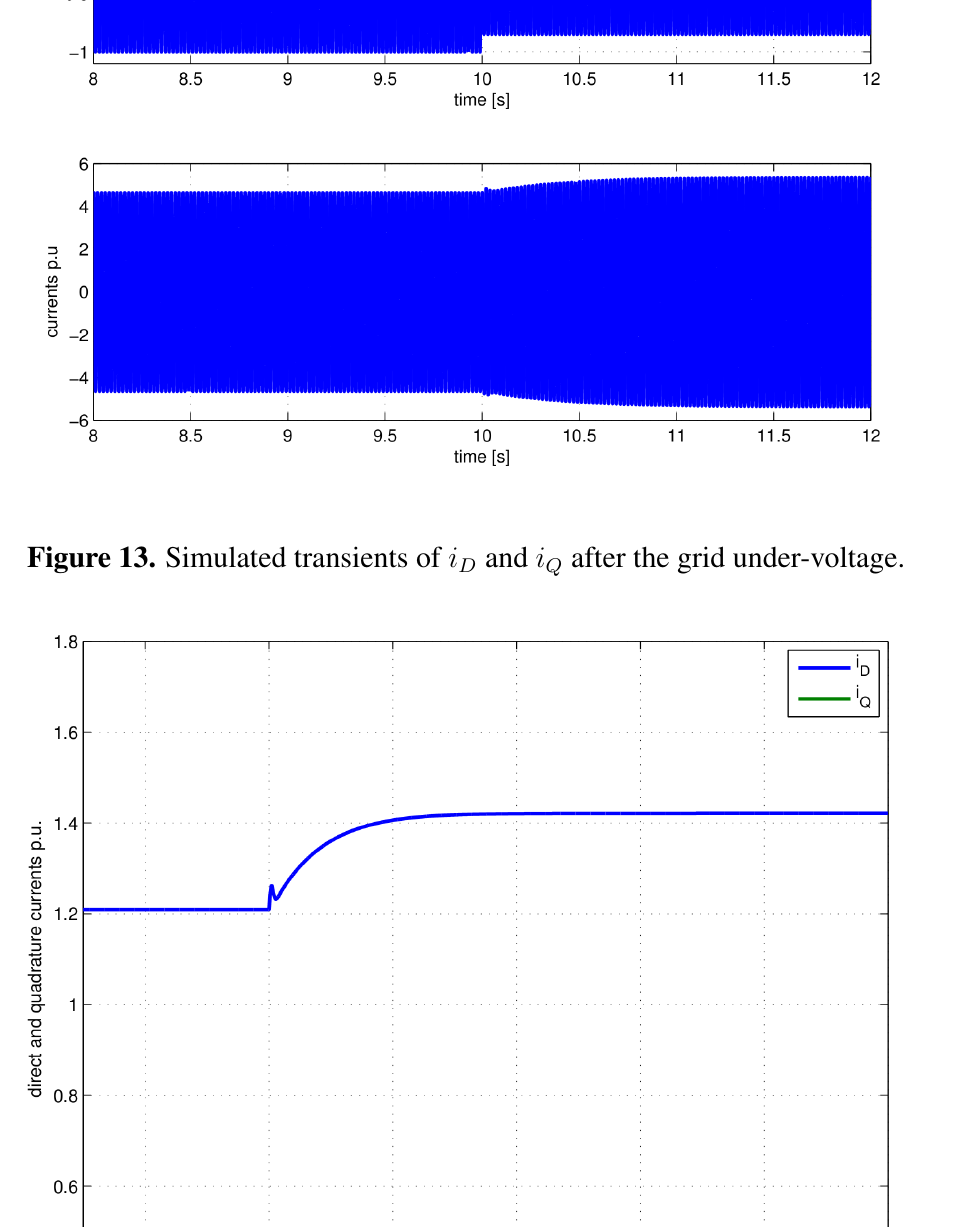
Figure 12. Grid under-voltage and the corresponding current transient.